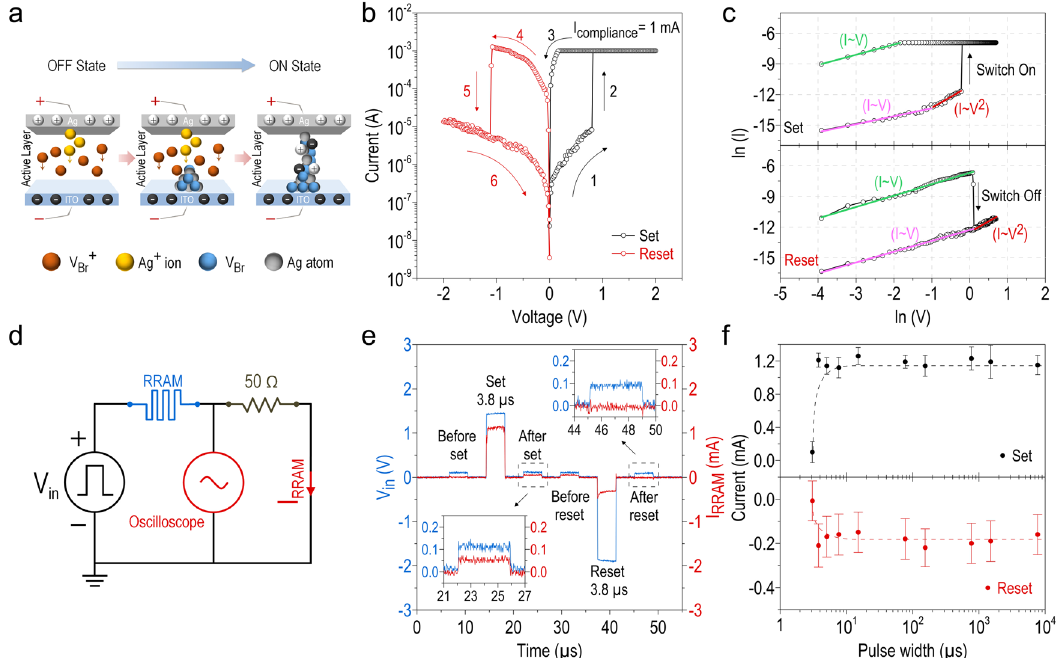
Fig. 4 Resistive switching of CsPbBr 3 QD-based RRAM. a Illustration of resistive switching in the CsPbBr 3 QD-based RRAM at the initial stage (left), during the migration of Ag + cations and V Br + vacancies (middle), and the fi nal formation of the V Br conducting channel and the Ag fi lament (right). b Typical I – V characteristic of the CsPbBr 3 QD-based RRAM by setting the compliance current to I CC = 1 mA. c Same as b , but plotted in a log-log scale with fi tting lines corresponding to different conduction mechanisms (pink and red lines represent the linear Ohmic and the quadratic space-charge-limited conductions in HRS, respectively, whereas green line represents the linear Ohmic conduction in LRS) for Set (top) and Reset (bottom) conditions. d Circuit diagram of the measurement system for examining the resistive switching speed of the RRAM. e Transient responses of the RRAM during the set (1.5 V, 3.8 μ s) and reset ( − 2.0 V, 3.8 μ s) processes. Insets: enlarged time trace of the read pulses (0.1 V, 3.8 μ s) fed into the RRAM after set (lower left) and reset (upper right) pulse biases. f I RRAM vs. pulse width of the applied bias V in for both set (top) and reset (bottom) processes. Error bars represent plus/minus standard